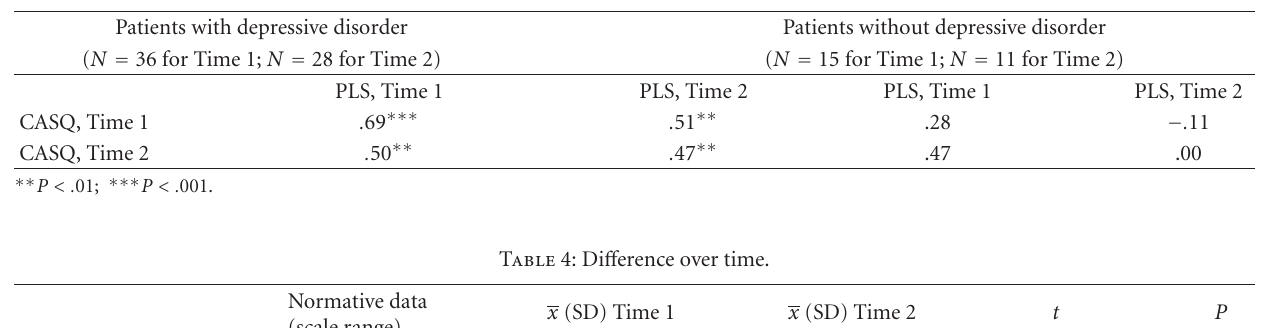
Table 3: Correlation between attributional style and pleasure capacity.